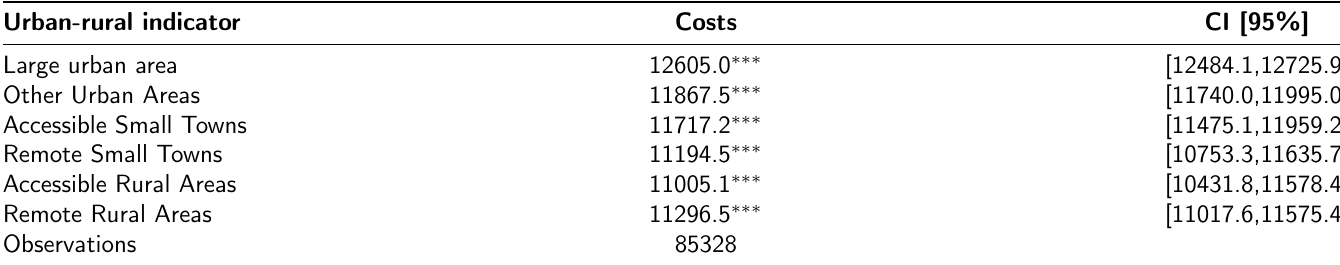
Supplementary Table 6: Univariate analysis GLM - rural-urban indicator